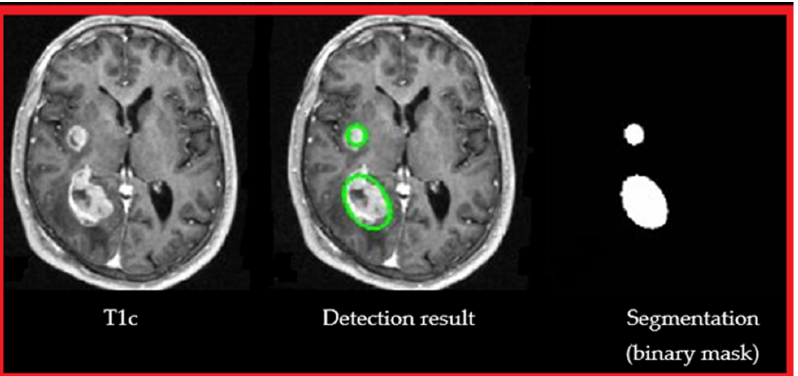
Figure 5. Segmentation result (see Section 4): MRI sequences: T1, T2, T1c, FLAIR, Ground Truth, and segmentation.